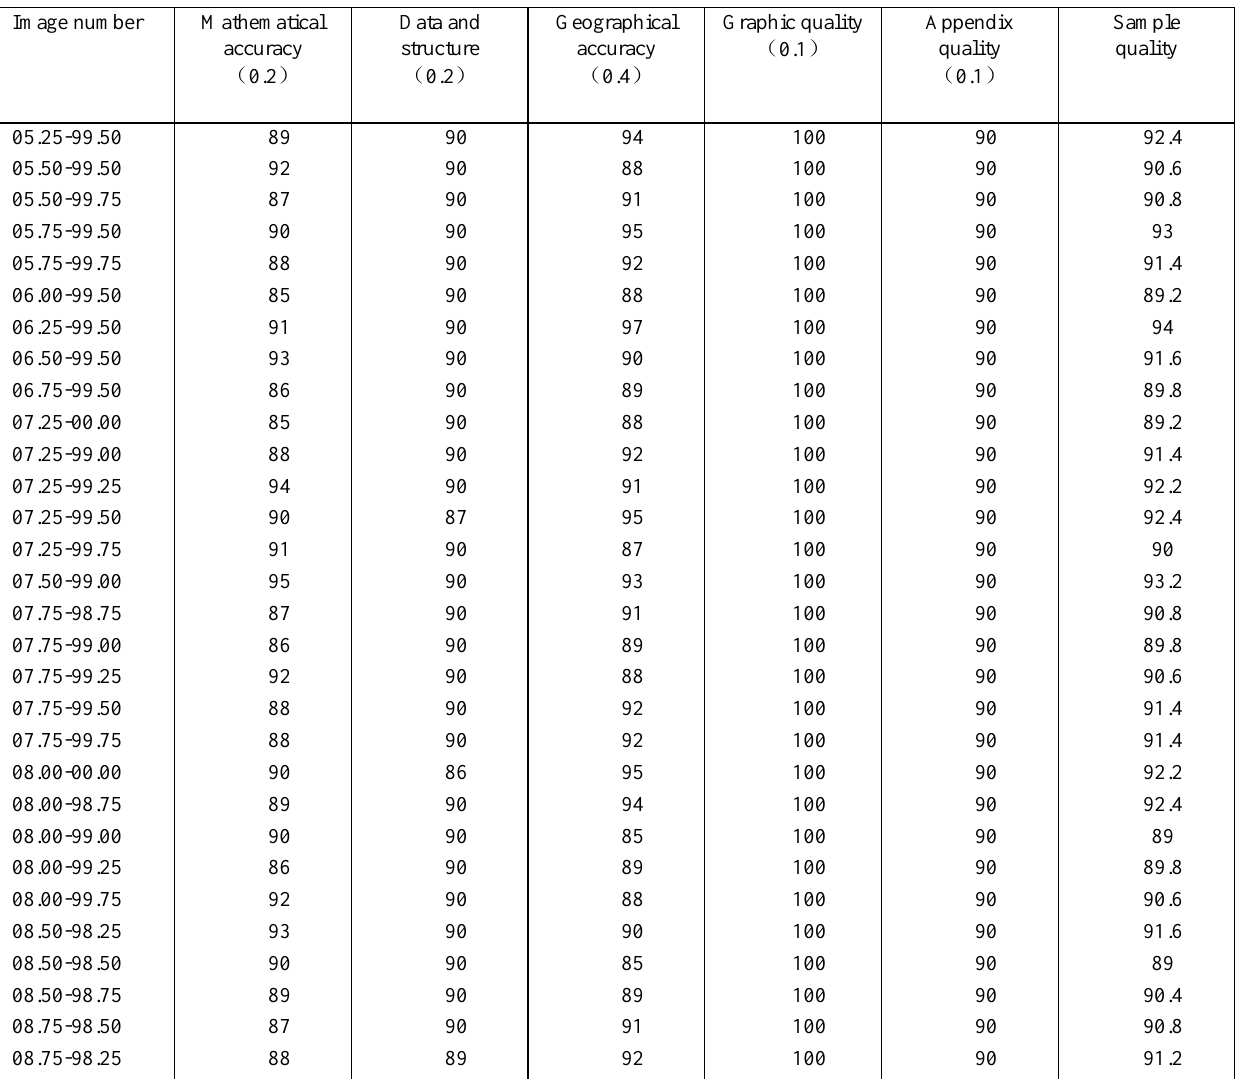
Table 7. Product sampling and testing score of 1:500 DLG in study